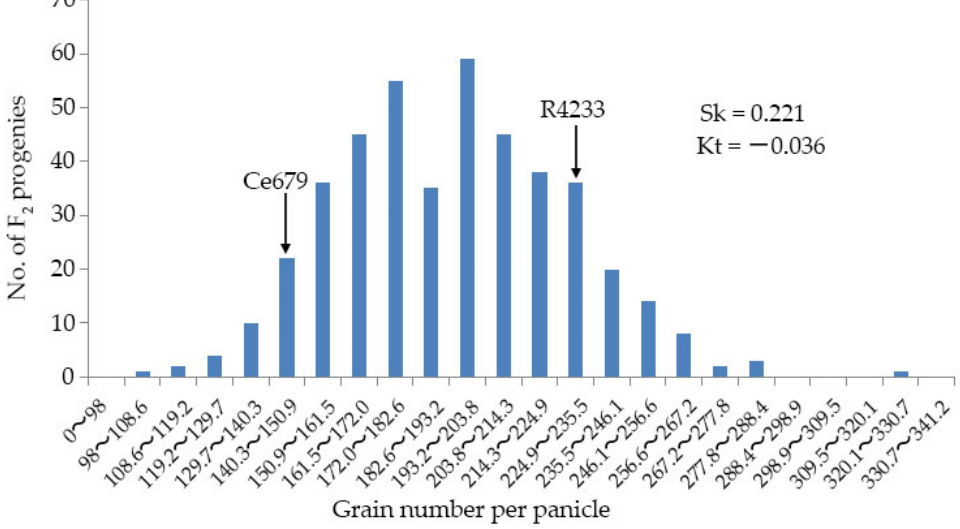
Figure 2. Frequency distribution of GNPP of the progenies derived from the crossing between Ce679 and R4233. The back arrows show the mean values of the distribution in Ce679 and R4233.